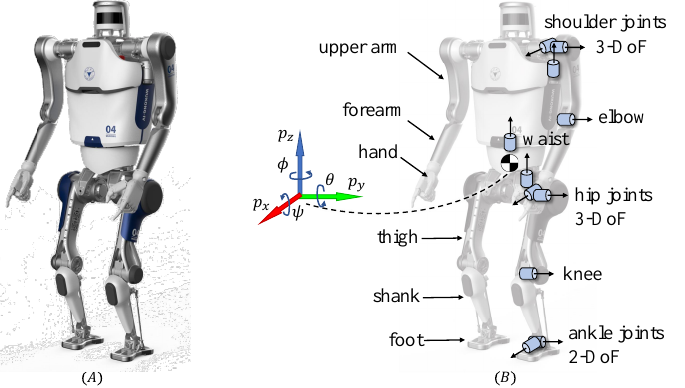
Figure 1. ( A ) Picture and hardware description of Wukong-IV humanoid robot. ( B ) Diagram of joint and link definition for Wukong-IV humanoid robot abstract